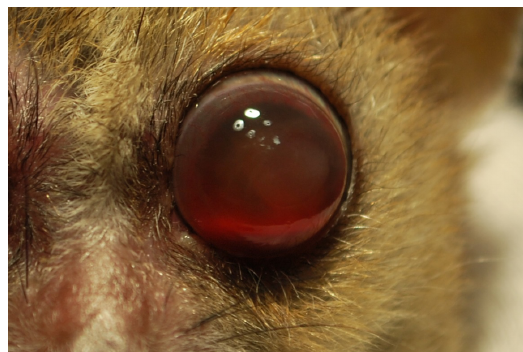
Figure 5. Eight-year old individual with bilateral blood accumu- lation (Hyphema) in the anterior eye chamber, presumably as a re- sult of inflammatory processes of the uvea (uveitis). The blood cells accumulate at the bottom of the anterior eye chamber in order to follow